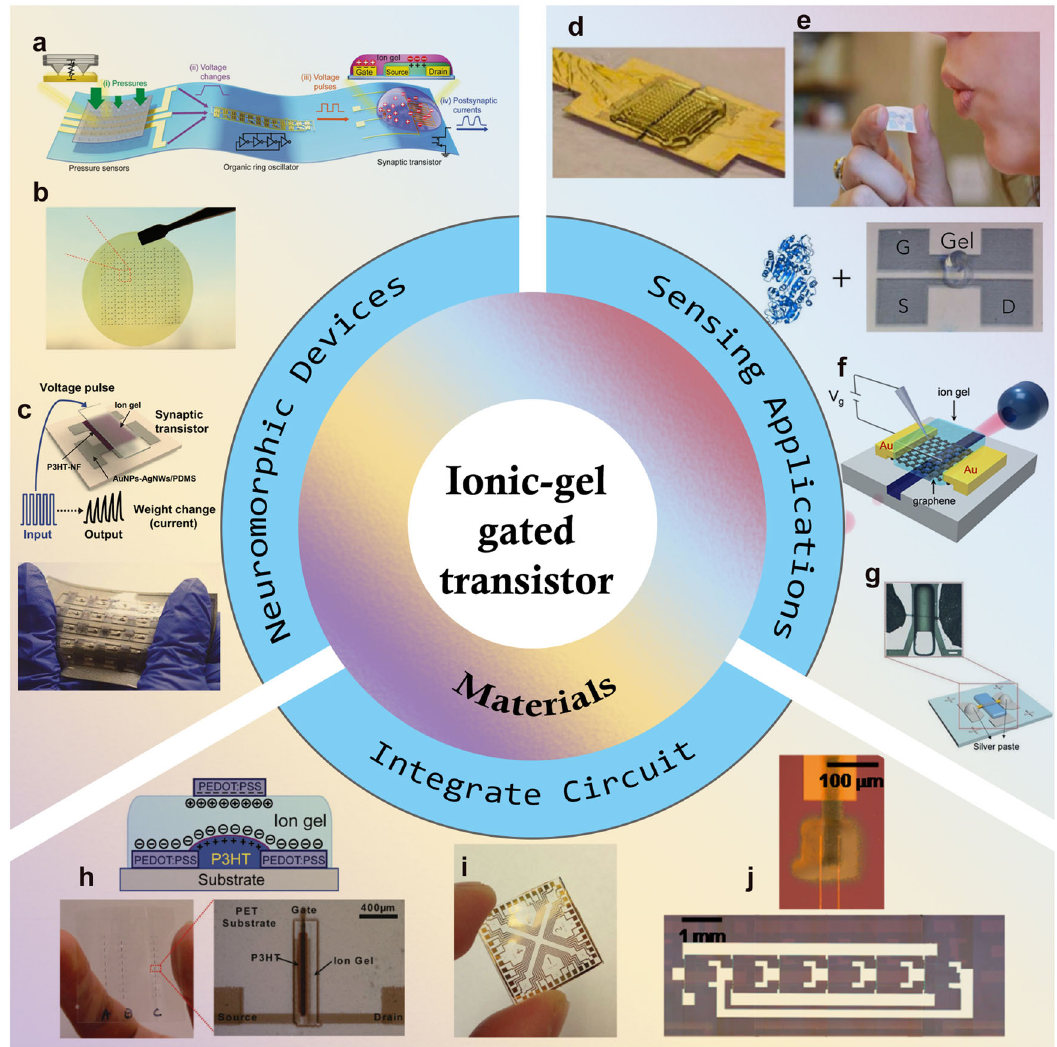
Fig. 1 Prospective applications of ionic gel-based electronics. a An arti fi cial afferent nerve made of pressure sensors, an organic ring oscillator, and a synaptic transistor. Reproduced with permission 127 . Copyright 2018, Elsevier. b Optical photo of Ionic-gel transistor. Reproduced with permission 118 . Copyright 2020, Wiley-VCH. c Schematic device structure and demonstration of multiple presynaptic pulses induced synaptic transistor responses 26 . Copyright 2019, Elsevier. d A real optical image of the OECT iontronic pressure sensor.